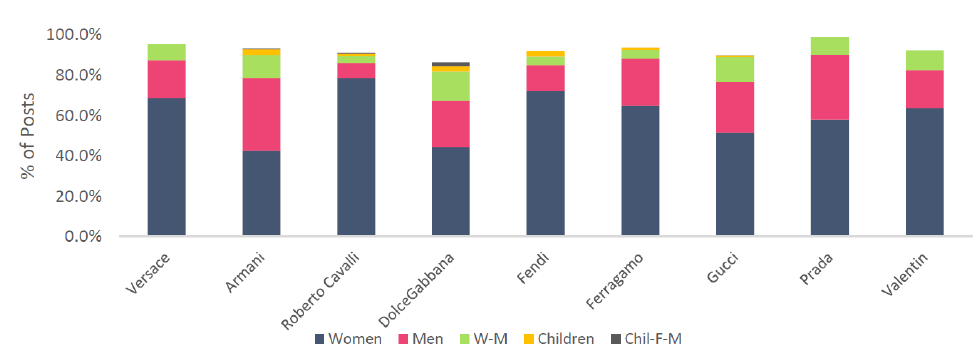
Figure 6. Share of each target (women, men, children) by brands.